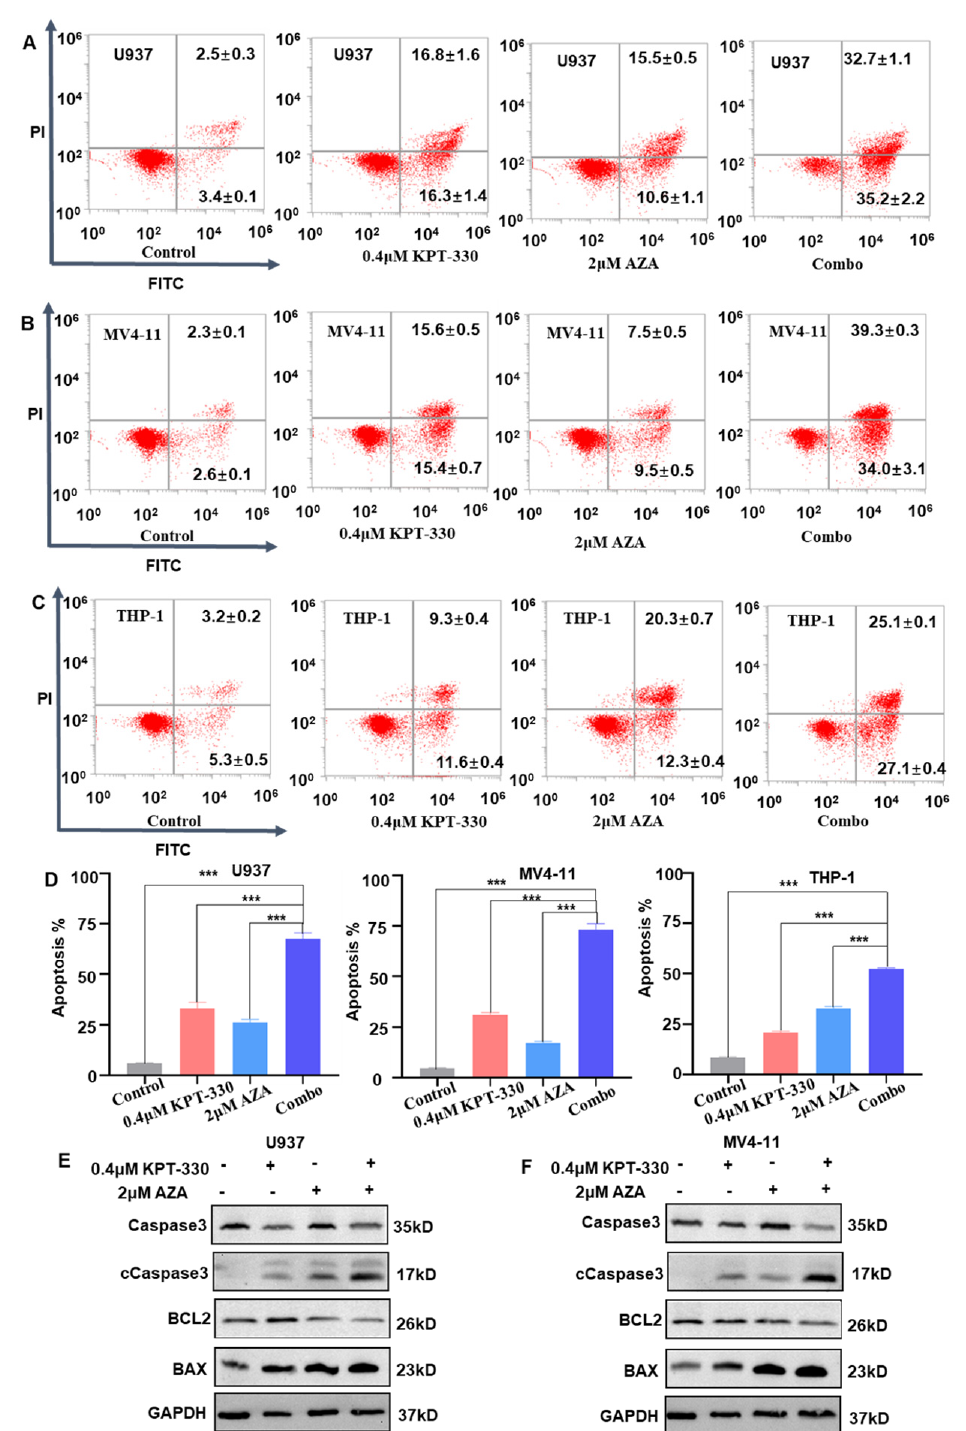
Figure 2. Synergistic effect of KPT-330 with AZA on apoptosis of AML cells. ( A ) Effect of KPT-330 with AZA on apoptosis of U937 cells. ( B ) Effect of KPT-330 with AZA on apoptosis of MV4-11 cells. ( C ) Effect of KPT-330 on apoptosis of THP-1 cells. ( D ) Quantitative bar charts for the three cell lines. ( E , F ) Western blot of the apoptotic proteins (Caspase3, cleaved Caspase3 (cCaspase3), BCL2, and BAX) in the U937 and MV4-11 cells upon the drug treatment (DMSO, KPT-330, AZA, and combo). *** p <